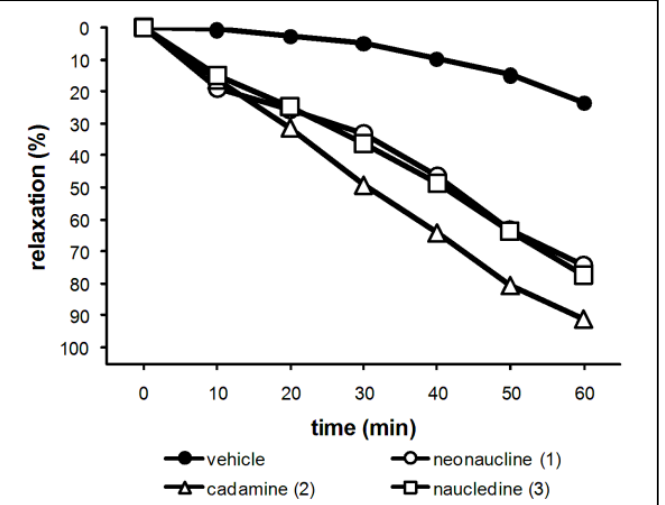
Table 2. 1 H-NMR (in DMSO-d6 and CDCl of naucledine ( 3